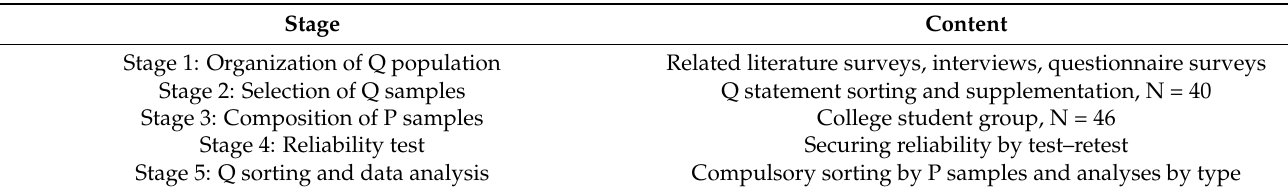
Table 1. Study Process.